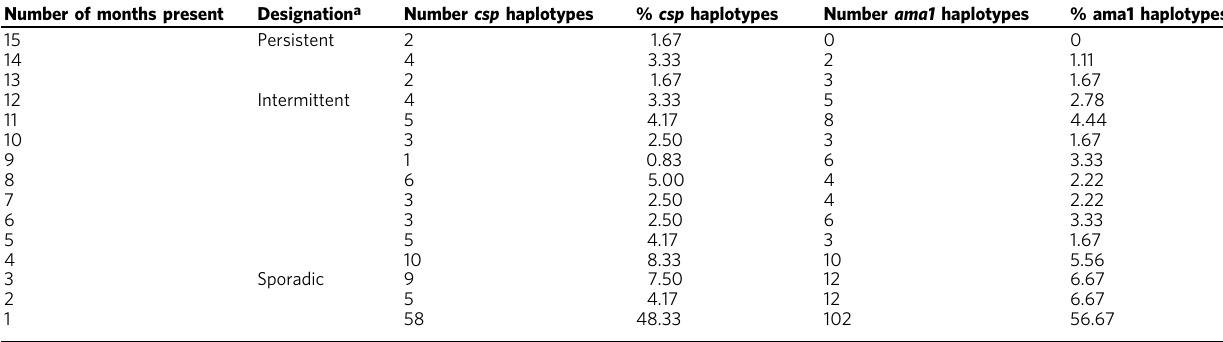
Table 2 Distribution of number of months unique csp / ama1 haplotypes were